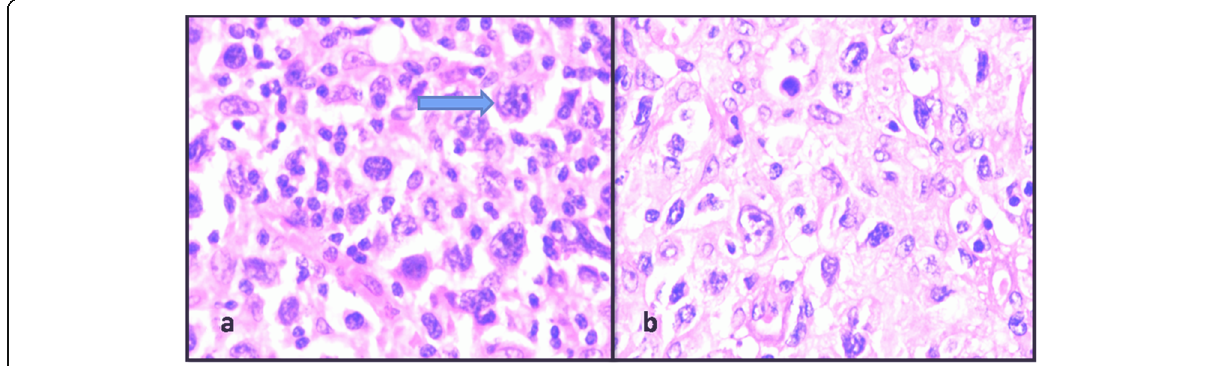
Fig. 1 Histology: a , b H&E stained section showing a polymorphous population of cells with numerous multilobated cells